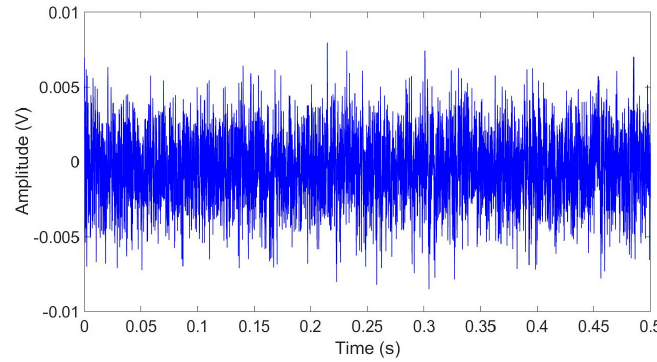
Figure 5. Sample random data generated by the accelerometer at rest, measured using a sample rate of 25 kSps.